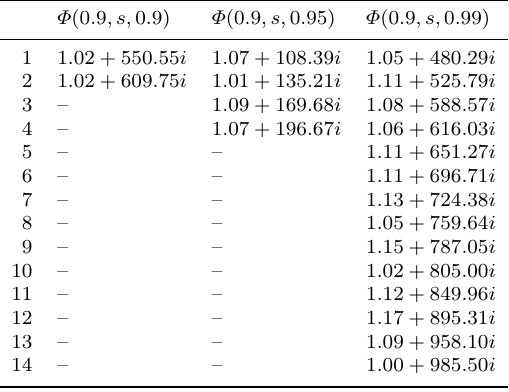
Table 2. Coordinates of zeros of the function Φ ( q,s,α ) in the region R . Φ (0 . 9 ,s, 0 .